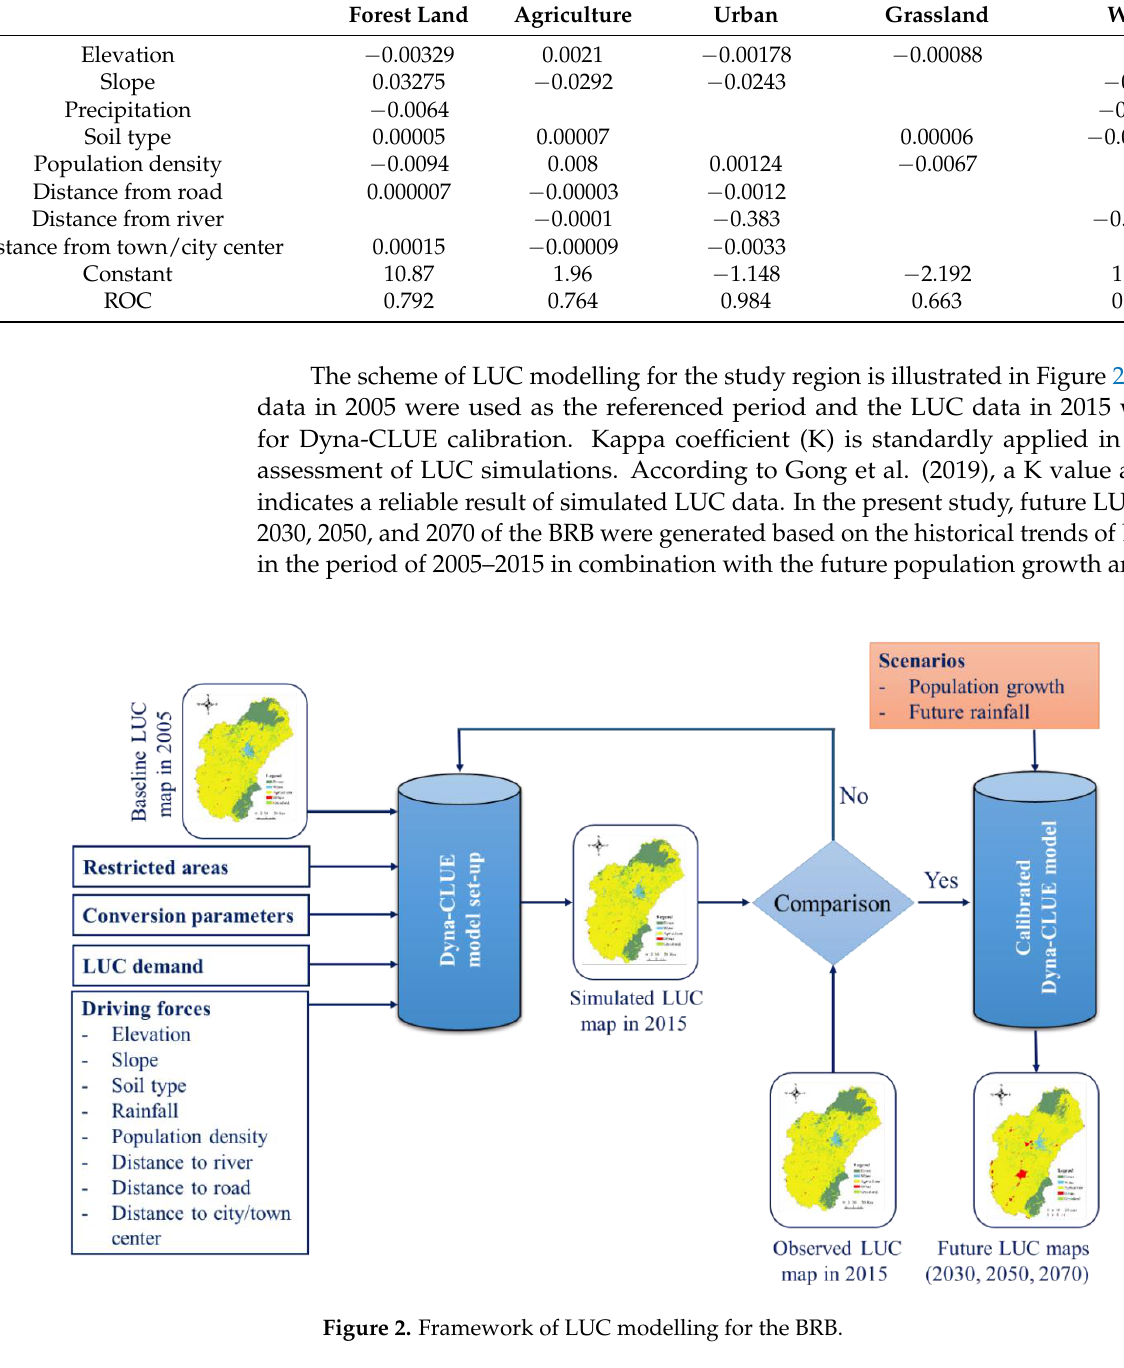
Table 2. Regression coefficients of the driving forces for different LUC types in the study region. Forest Land